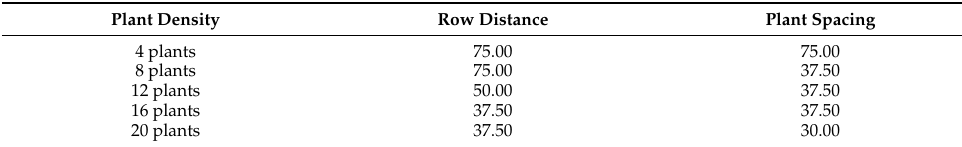
Table 2. Row distance and plant spacing of each planting density